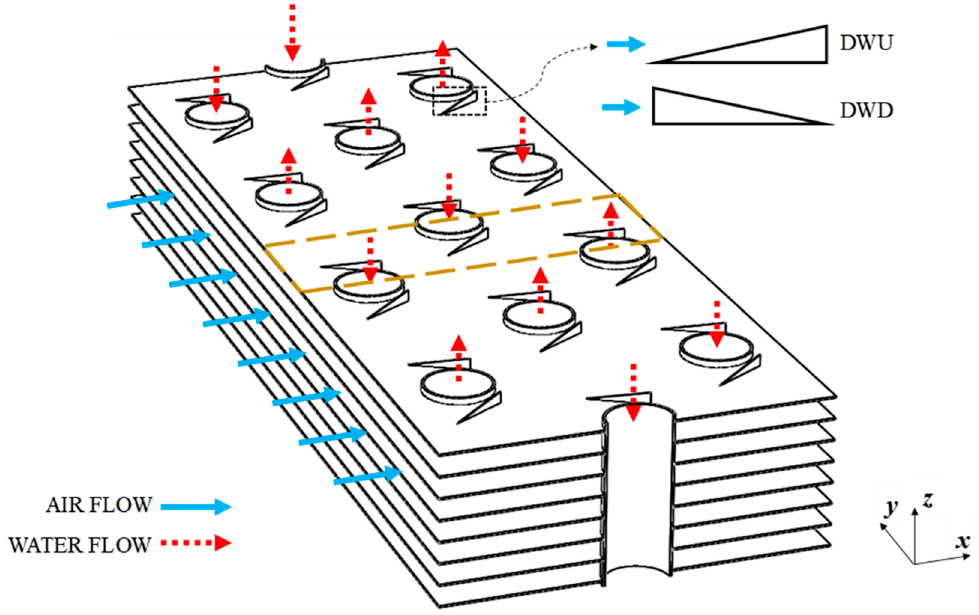
Figure 2. Segment of the crossflow air-to-water fin-and-tube heat exchanger with